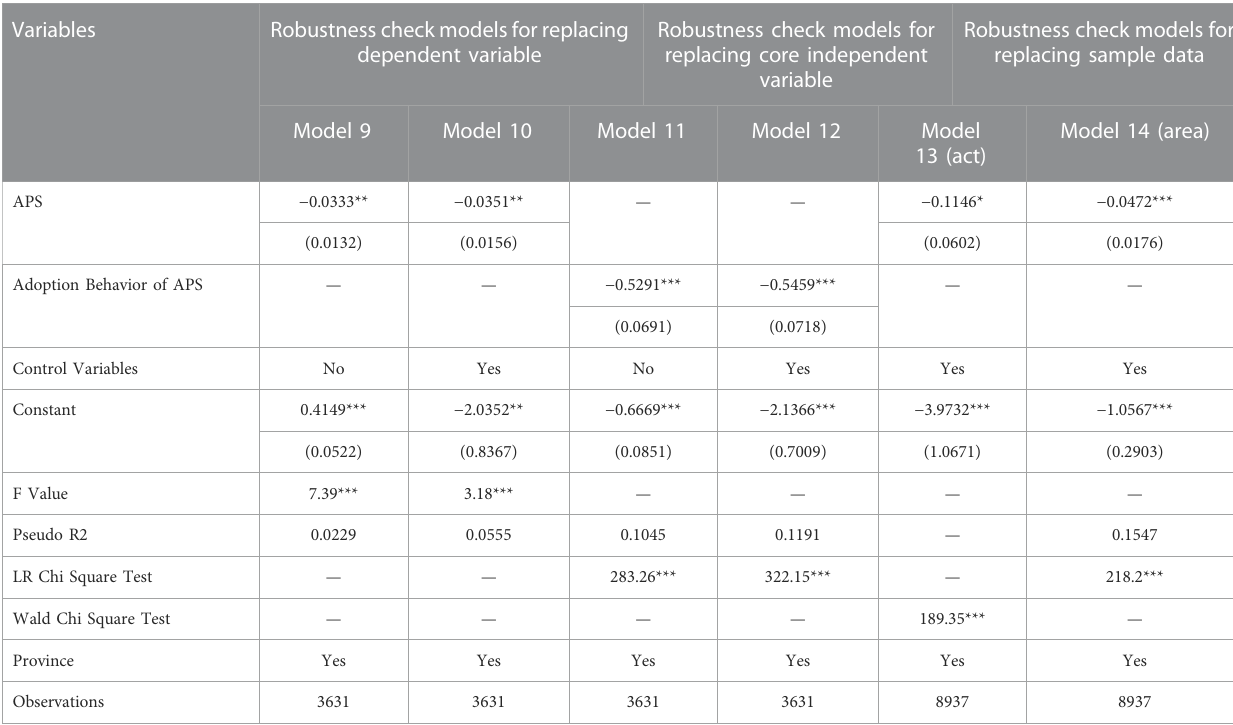
TABLE 3 Robustness test results. Variables Robustness check models for replacing dependent